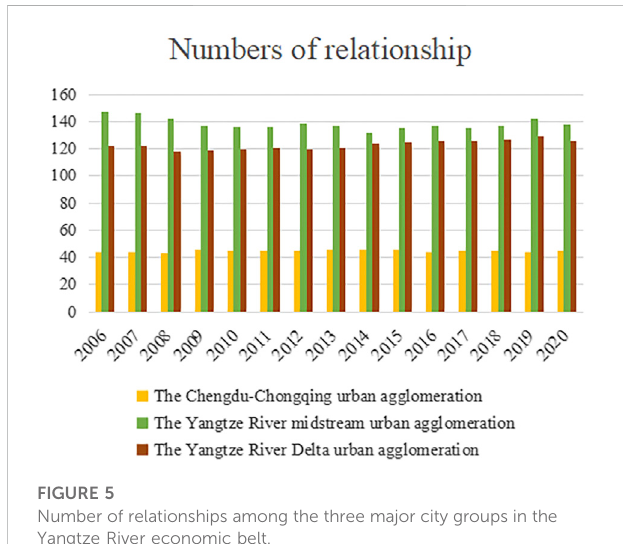
FIGURE 5 Number of relationships among the three major city groups in the Yangtze River economic